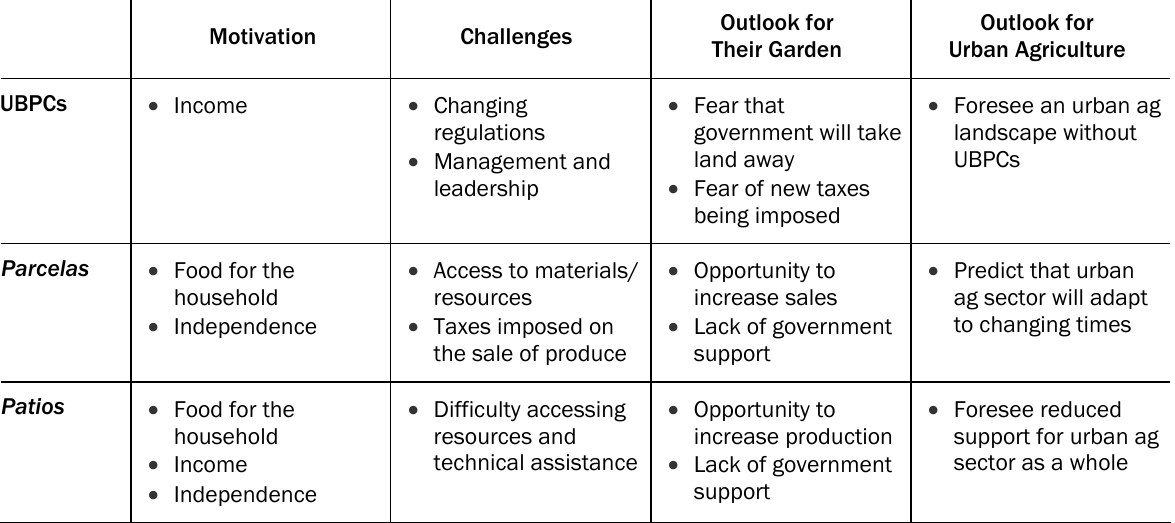
Table 3: Summary of Interview